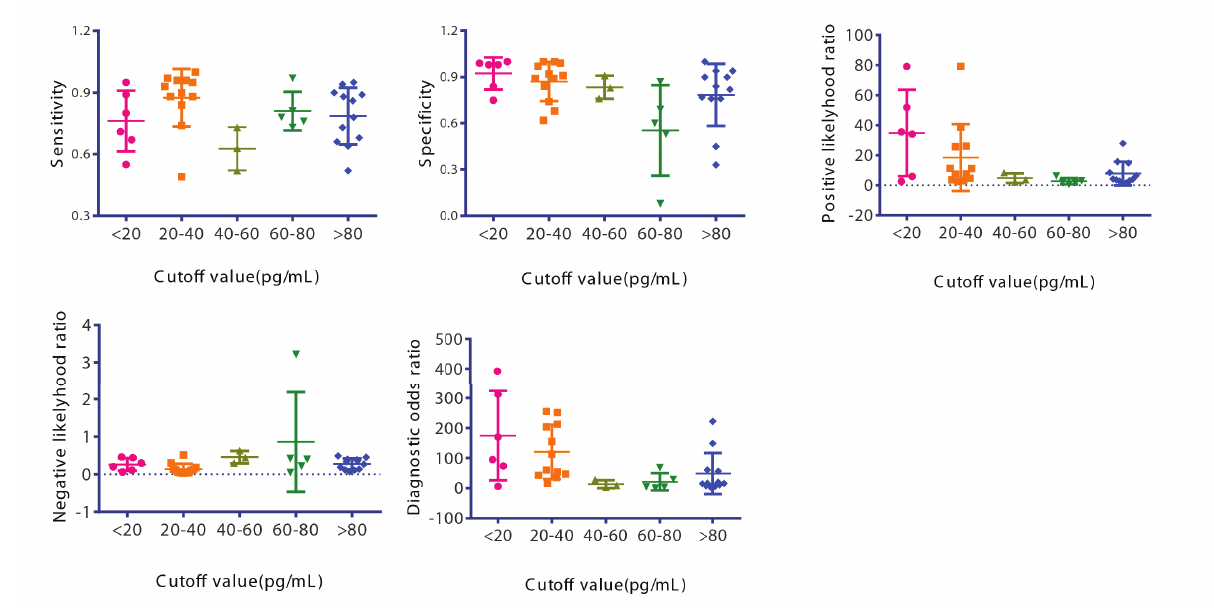
corticoids, broad-spectrum antibiotics and